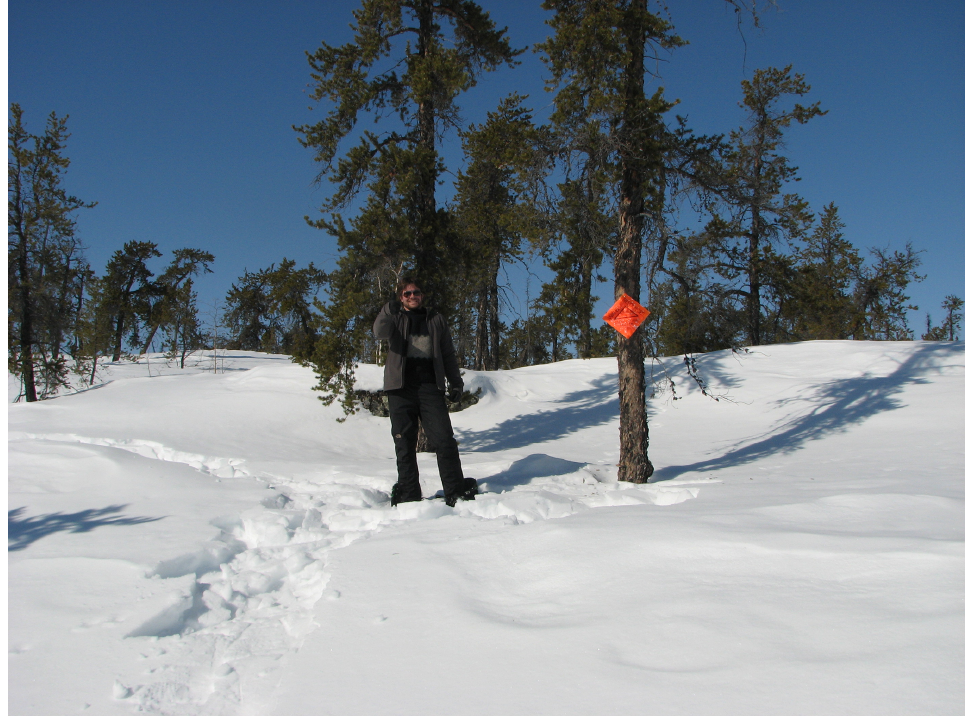
Figure 9. The beginning of one of the exposed bedrock snow courses. Note the sparse jack pine individuals and exposed rock behind Ross Phillips.